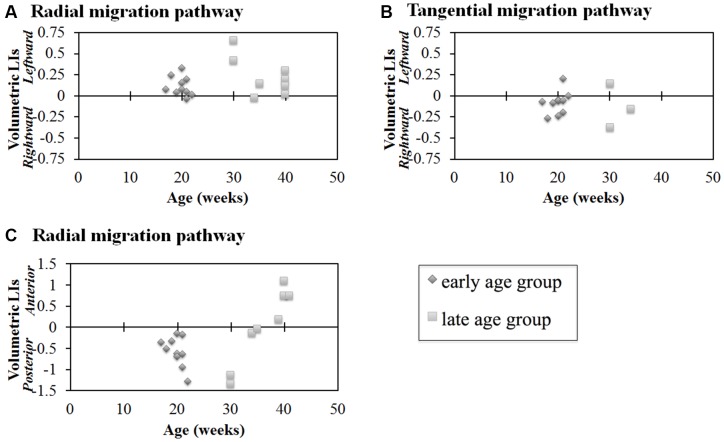
Laterality indices (LIs) for hemispheric asymmetry (A,B) and anterior-posterior asymmetry (C) of radial pathways (A,C) and tangential pathways (B). Radial pathways in the early age group revealed significant hemispheric asymmetry (p = 0.0045) (A). In contrast, significant hemispheric asymmetry was not observed in the tangential pathways (p > 0.01) (B). In the early age group, the posterior region was significantly larger than the anterior region (p < 0.0001, [1.75 × 10−5]) (C). In contrast, no significant difference was observed in the late age group (C). Diamond shape: early age group (17–22 GW); square: late age group (30–40 GW).